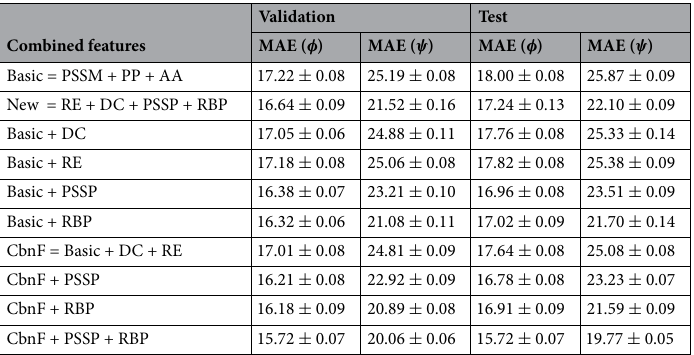
Table 2. The MAE of combined features in predicting the torsion angles using ESIDEN on the D2020 dataset.